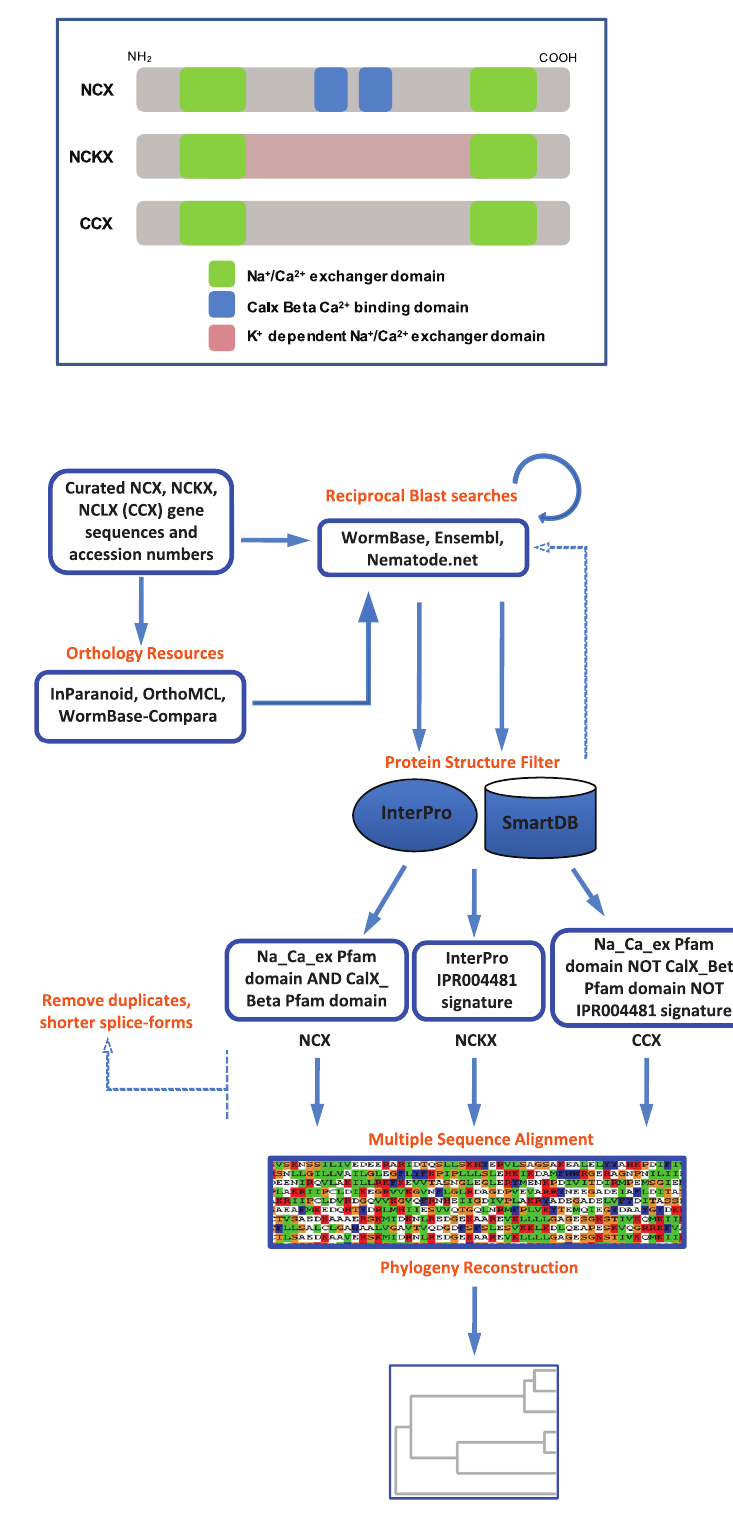
Figure 1. Structures within NCX, NCKX, and CCX proteins, and an overview of the pipeline used to detect orthologs of these proteins in twelve species of nematodes. ( A ) Cartoon depicting structures within the NCX, NCKX, and CCX (NCLX) proteins. ( B ) Overview of a pipeline used to detect orthologous sodium calcium exchanger genes in twelve different species of nematodes.